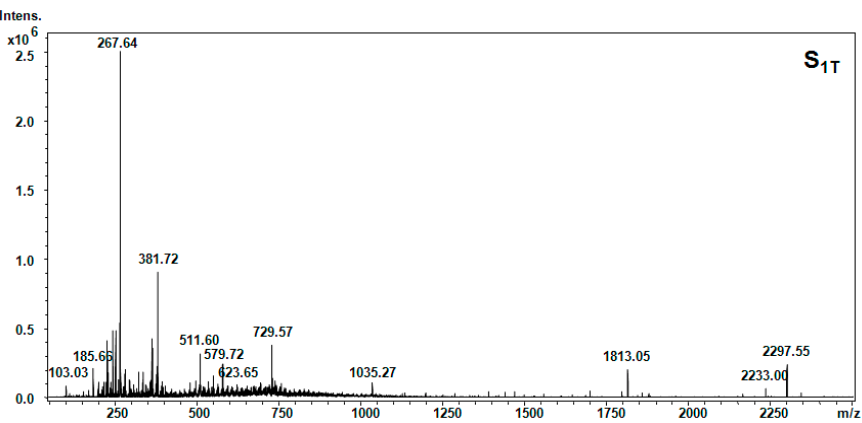
Figure 8. Positive ion mode nano-ESI-Chip-MS of the hellebore thionins in the petroleum ether fraction.